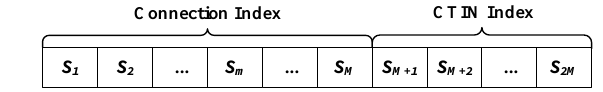
Figure 4. Encoding of particle i .